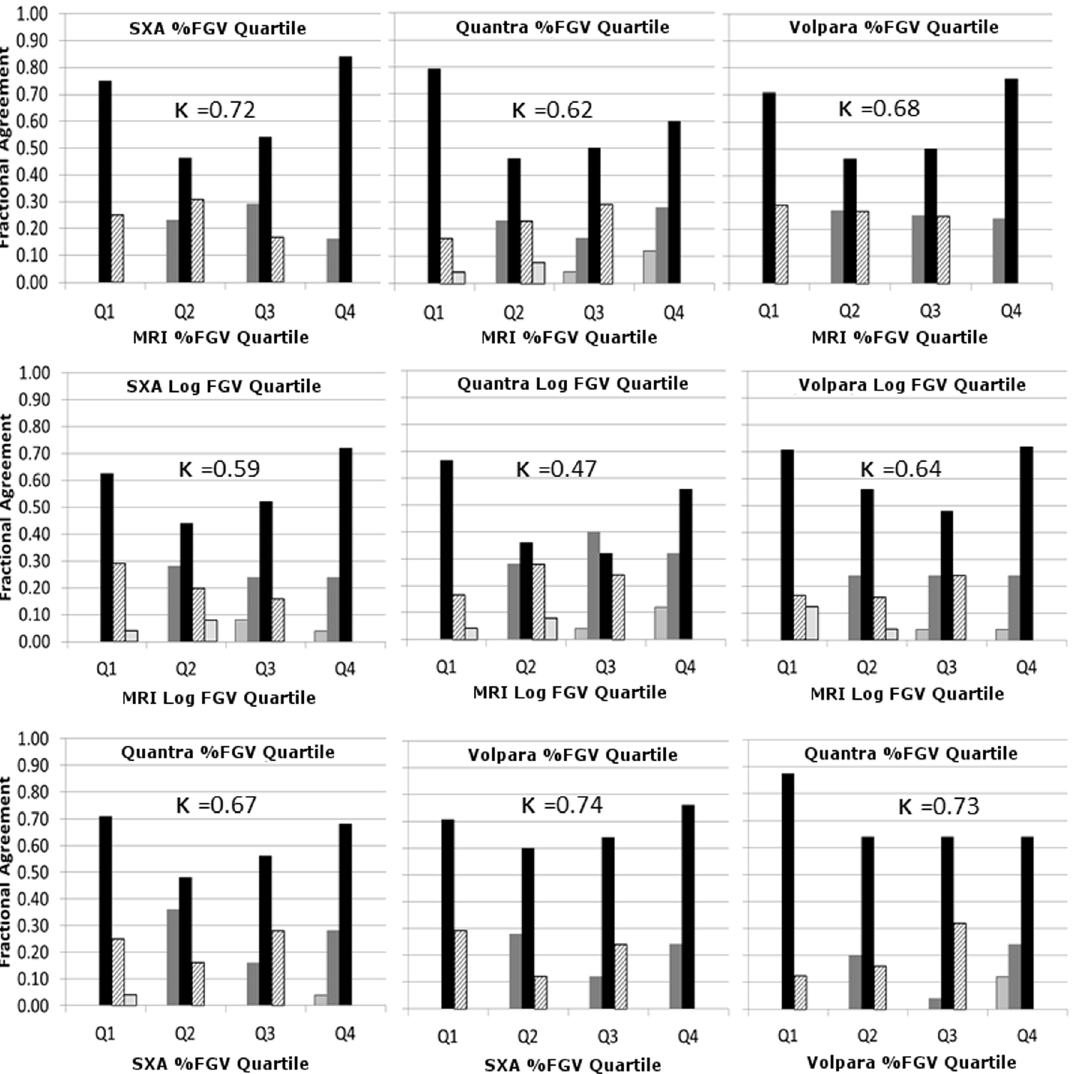
Figure 2. Comparison of quartiles classification for percent fibroglandular density (top) and log fibroglandular volume (middle) for MRI versus SXA (left), Quantra (center), and Volpara (right). The bottom row of plots show quartiles comparisons between mammographic density measures. Legend at right defines categories of agreement, where either the two compared method’s agree completely (black) or are off by one or two quartiles up or down in comparison with the other method.